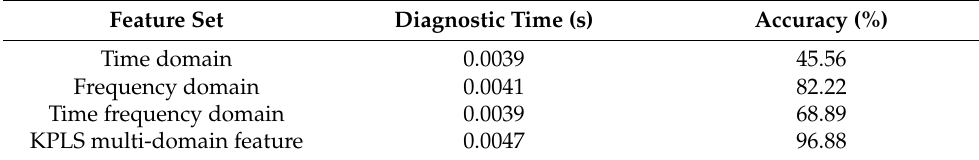
Table 9. Diagnosis results with different feature sets.